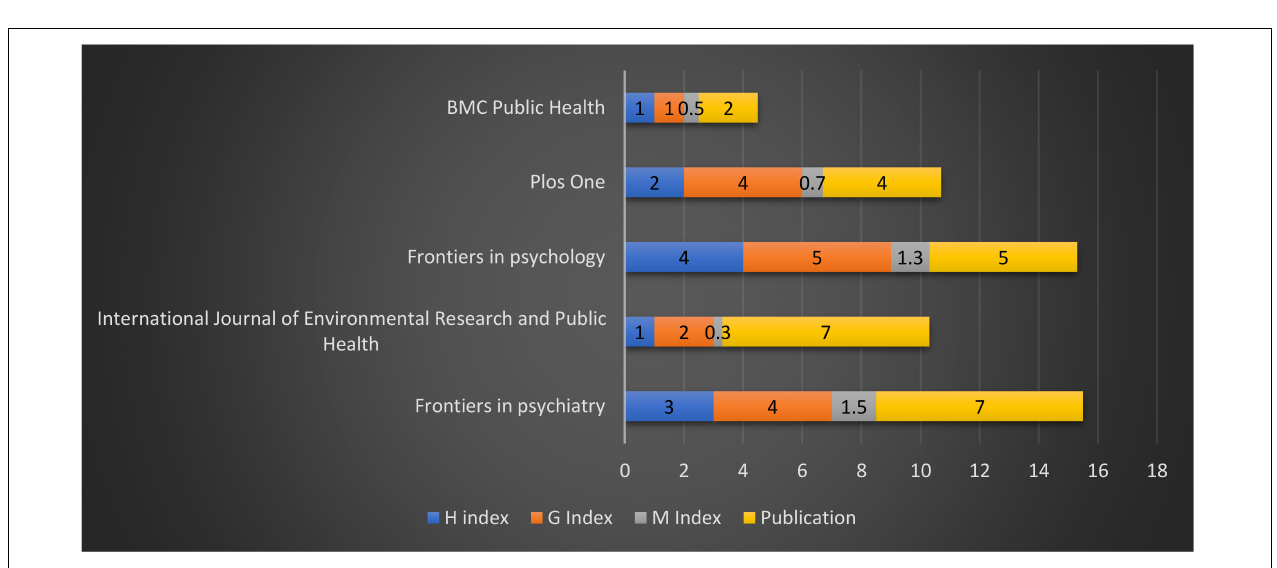
FIGURE 3 | Prominent